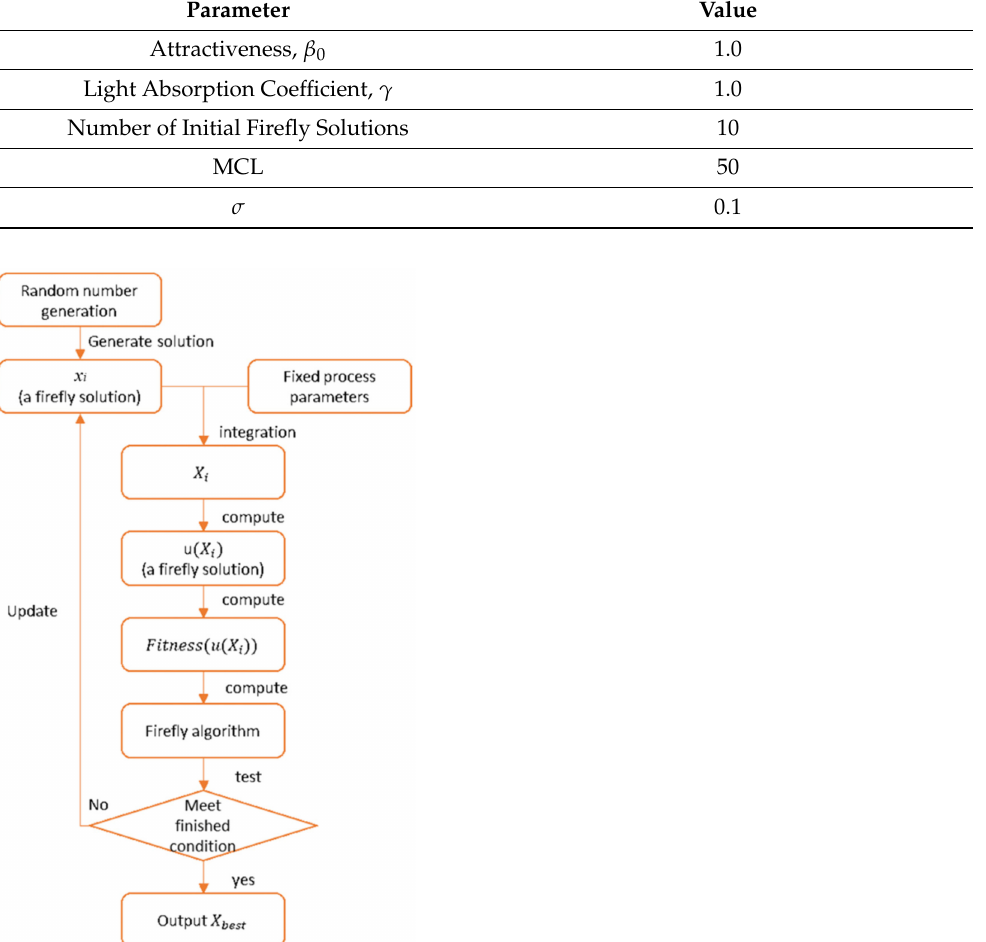
Figure 4. Flowchart of the FA used for optimizing the process